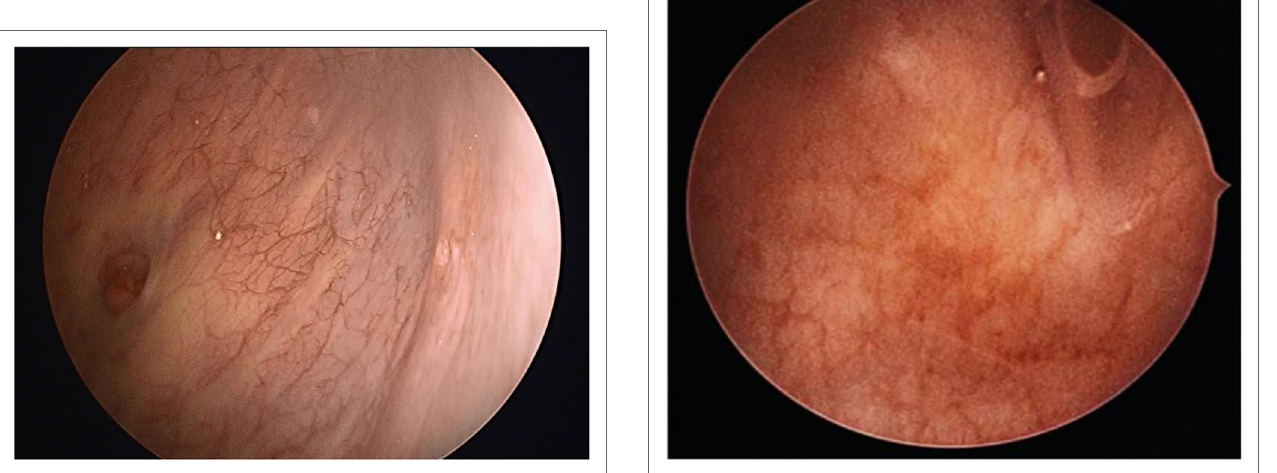
FIgURe 2 | Hysteroscopic view of the urinary catheter introduced through the fistula in the bladder.